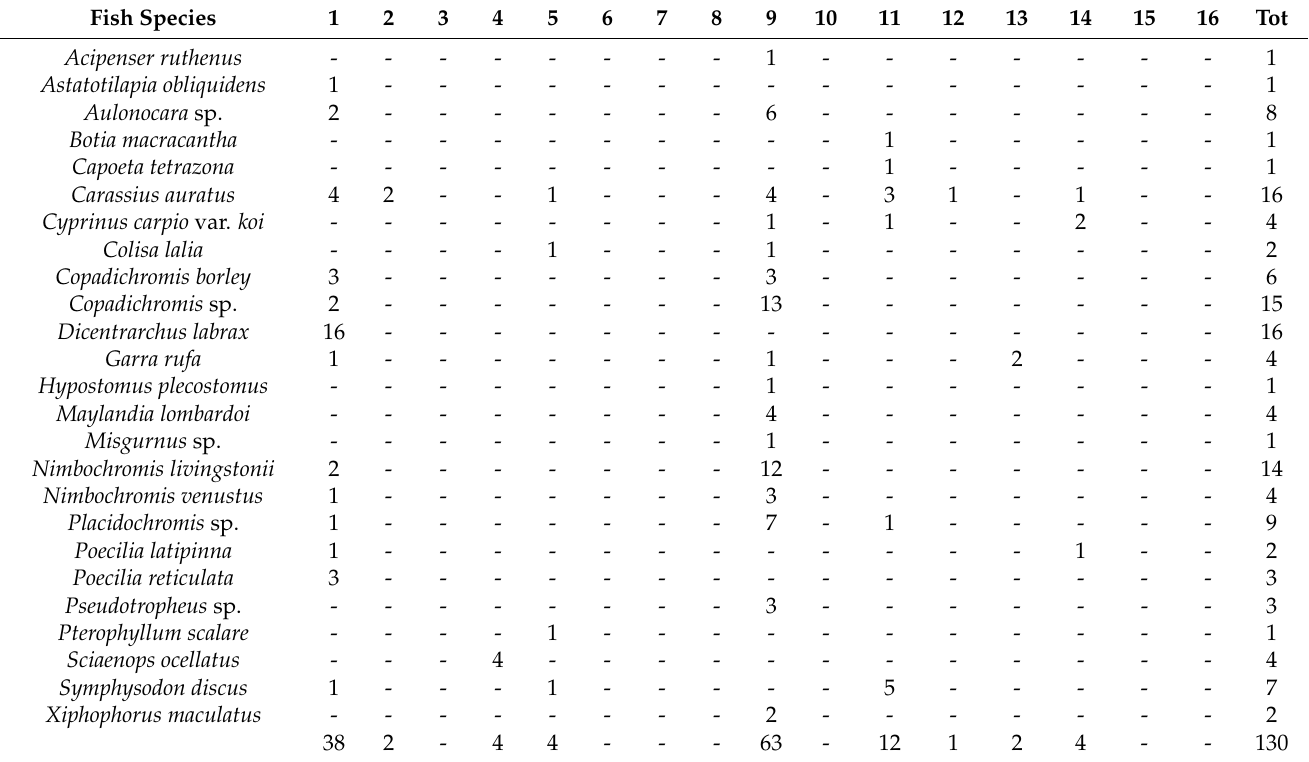
Table interpretation. 1: M. fortuitum ; 2: M. alvei ; 3: M. boenickei ; 4: M. brisbanense ; 5: M. conceptionense ; 6: M. farcinogenes ; 7: M. houstonense : 8: M. neworleansense ; 9: M. peregrinum ; 10: M. porcinum ; 11: M. senegalense ; 12: M. septicum ; 13: M. setense ; 14: M. arceuilense ; 15: M. lutetiense ; 16: M. montmartrense